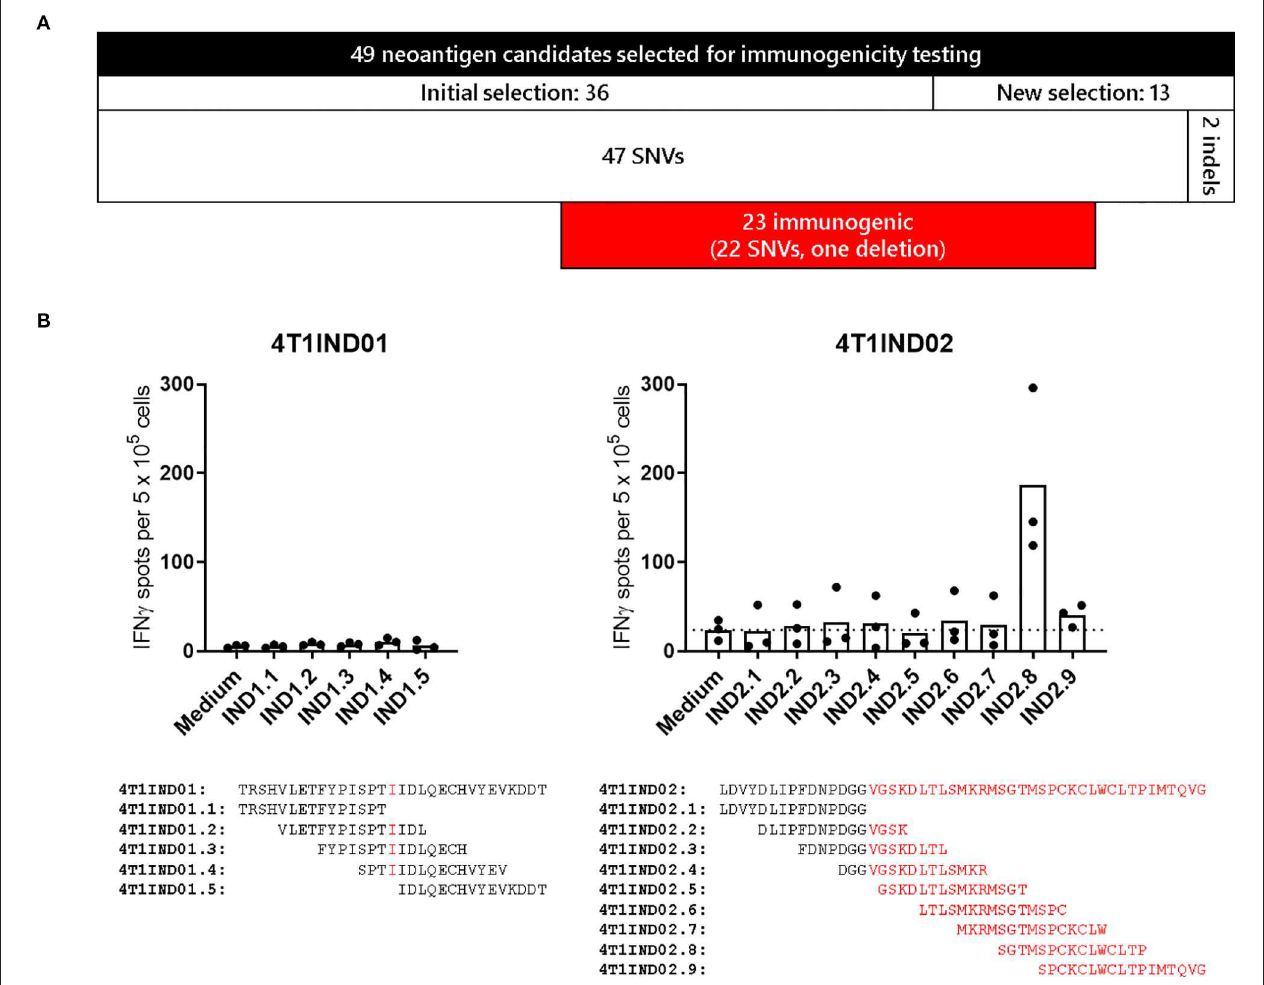
FIGURE 4 | (A) Numerical overview of selected neoantigen candidates for immunogenicity testing. 22 out of 49 assessed targets were immunogenic. (B) Immunogenicity testing of indels. Splenocytes of immunized mice ( n = 3 per indel) were tested 5 days after the last immunization via IFN- γ ELISpot for recognition of overlapping 15-mer peptides covering the complete 4T1IND01 and 4T1IND02 sequence as indicated below the graphs (11 amino acid overlap, new amino acids are highlighted in red). Columns indicate mean of spot counts. Peptide IND2.8 elicited IFN- γ spots > 2-fold over background (dotted line, medium